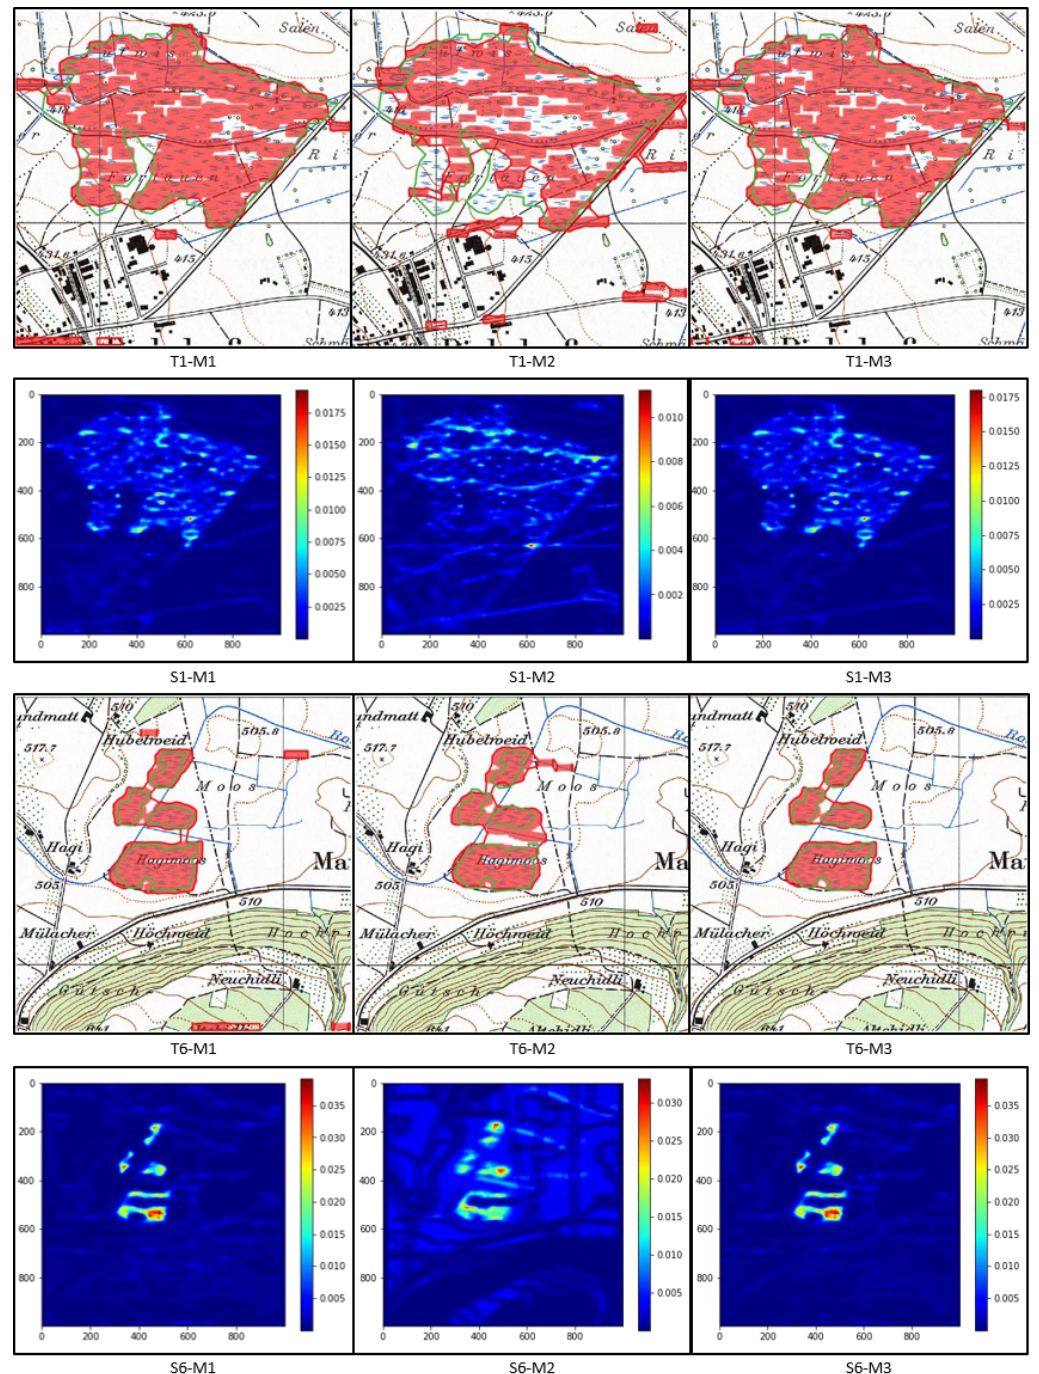
Figure 5. The detection results of Tile 1 and Tile 6 with their similarity score maps. T1-M1 refers to the result of Tile 1 generated by Model1, and S1-M1 is its corresponding similarity score map. The rest of the coded captions can be understood accordingly. Detected wetland signatures are marked in red bounding boxes; Red boundary is the generated wetland boundary and the green boundary marks the ground